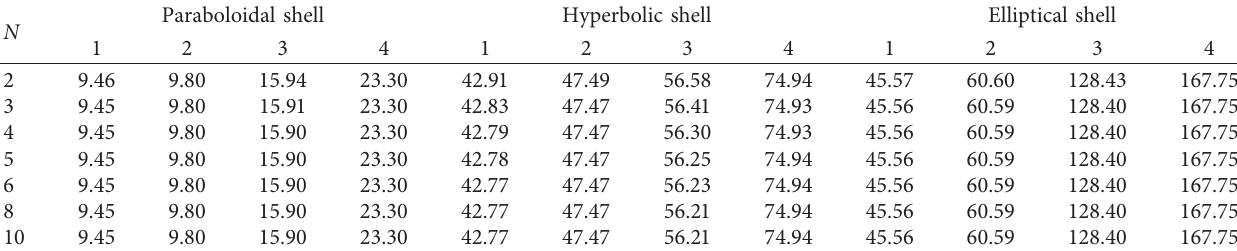
Table 1: Convergence analysis of number of segments for Sandwich FGP doubly curved structure. Paraboloidal shell N